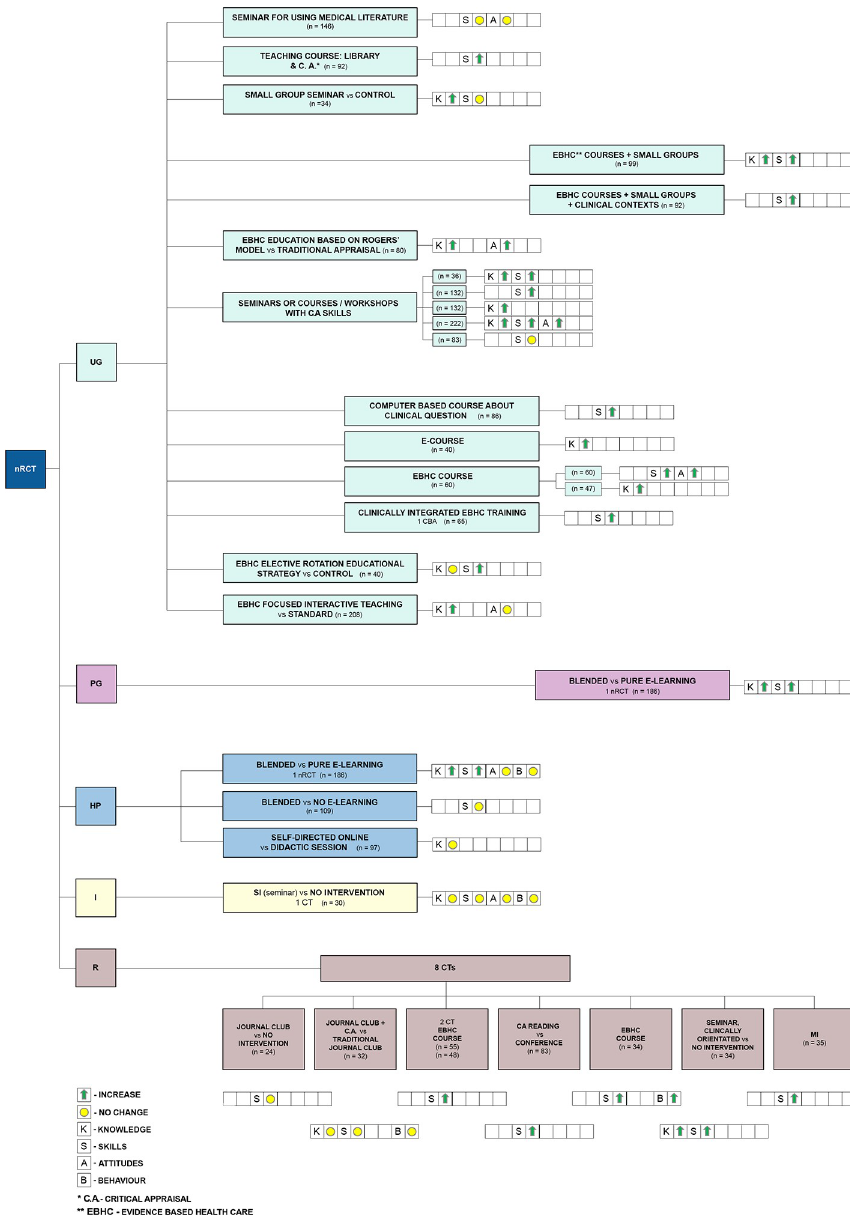
Fig 5. Illustrative display of the likely impact of different teaching approaches at different medical education levels–summary from non-RCT. CT–controlled trial, HP–health professionals, I–interns, MI–multiple intervention, non-RCT–non-randomised study, Qual–qualitative study, R–residents, SI–single intervention, UG–undergraduates; Explanation of the coloured symbols used are provided on the